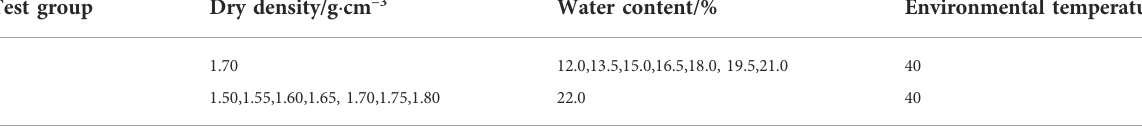
TABLE 1 Desiccation test